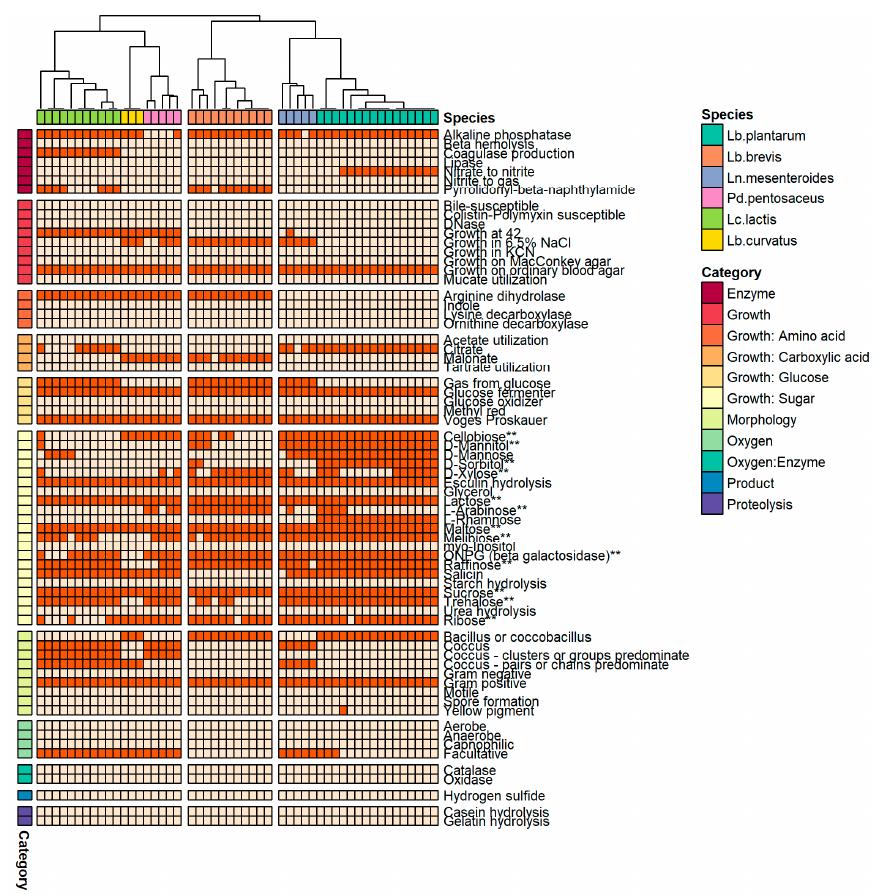
Figure 4. Clustered heatmap generated using a presence-absence data matrix of LAB phenotypic traits. Traits with a double asterisk (**) have been experimentally confirmed in the work of Tsigkrimani et al. (2022) [14]. Each column represents one isolate and each row one phenotypic trait. Isolates and traits are color-coded according to the legend. Presence (dark orange) or absence (light orange) of the trait in the respective isolates is